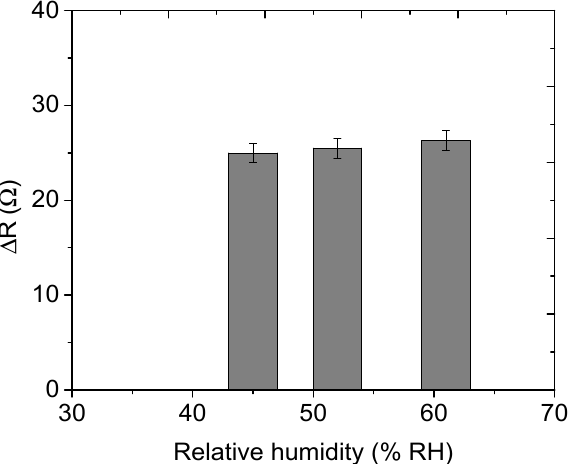
Figure 14. Humidity investigations on sensor 9.